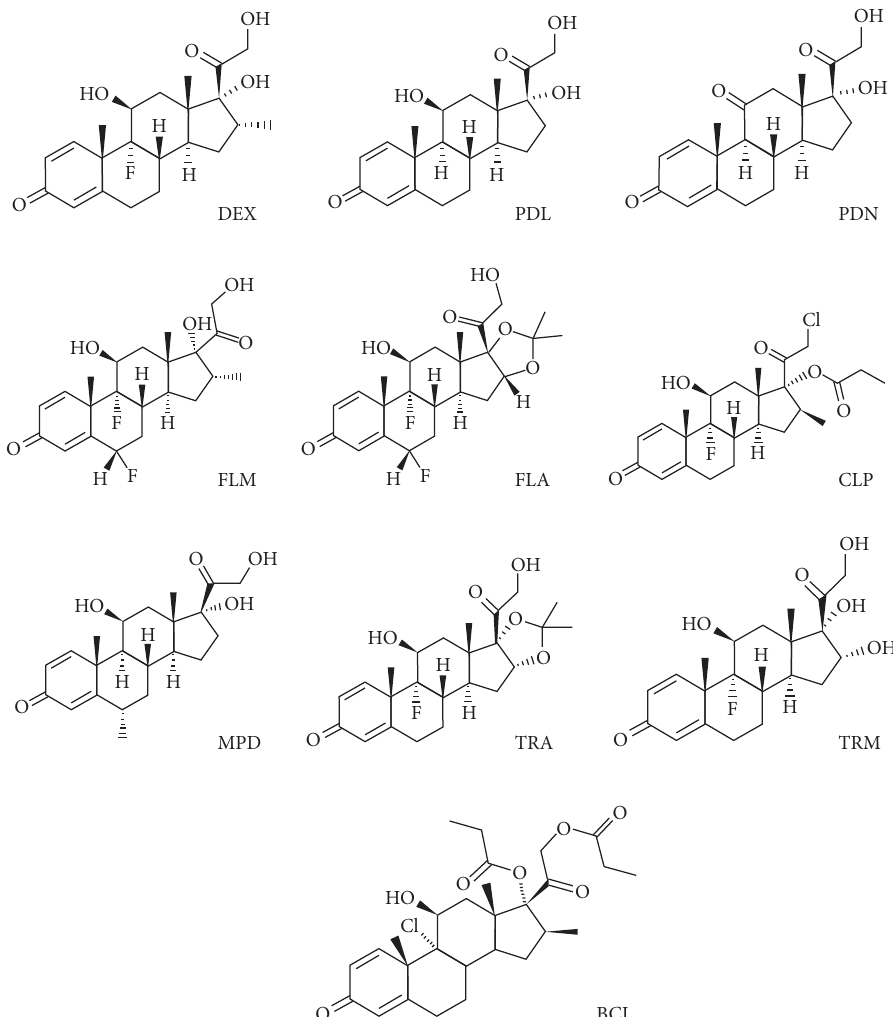
Figure 1: Chemical structures of